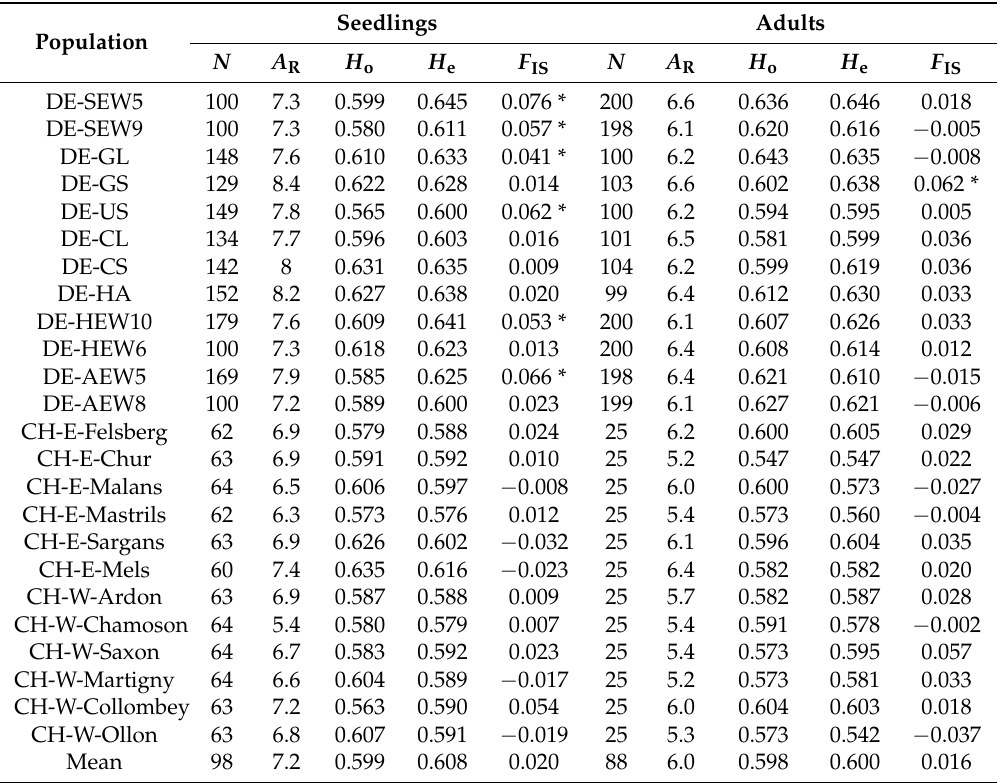
Table 3. Genetic diversity indices based on